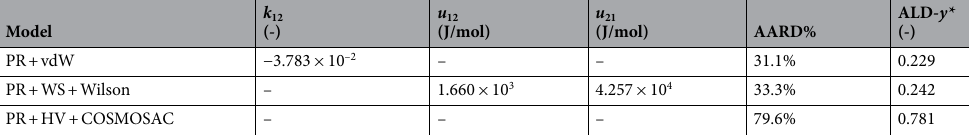
Table 6. Parameter values in PR EoS based thermodynamic models. * ALD- y = 1